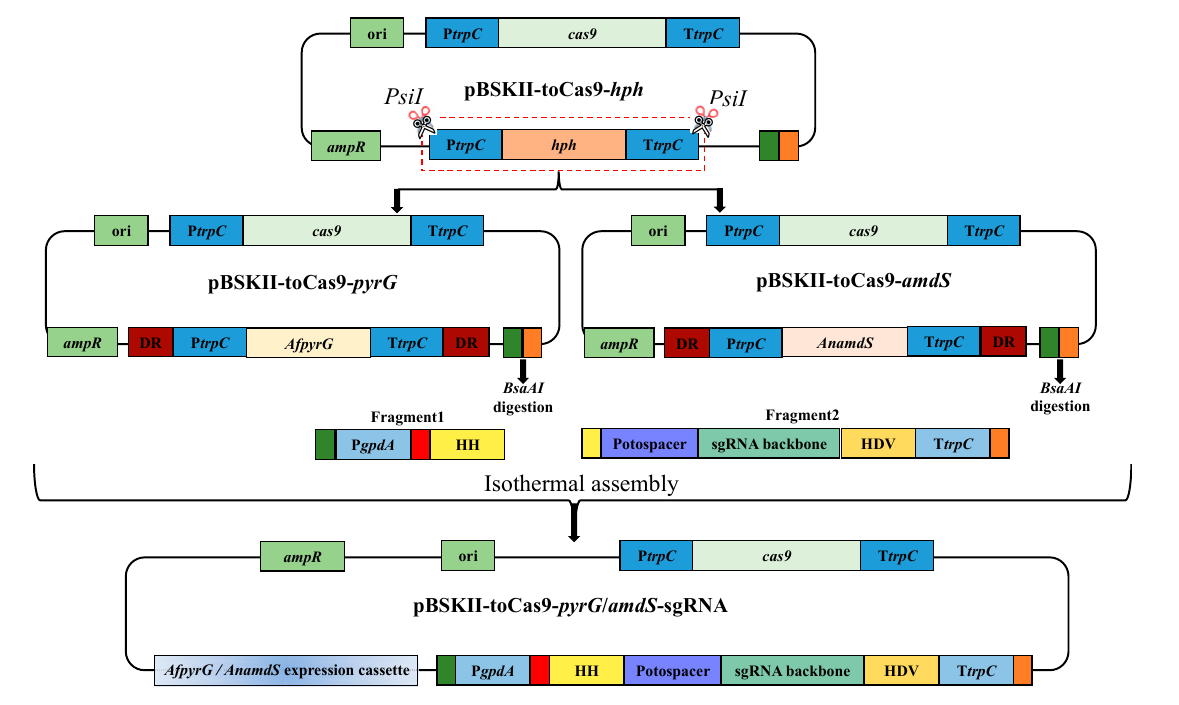
Figure 1. The construction of new CRISPR ‐ Cas9 vectors (pBSKII ‐ toCas9 ‐ pyrG / amdS ‐ sgRNA) for multistep gene deletion in marine ‐ derived fungi. The sequence of the pyrG / amdS expression cassette including P trpC promoter, T trpC terminator, and direct repeat was amplified. Then the amplified fragments were ligated into PsiI digested pBSKII ‐ toCas9 ‐ hph vector using isothermal assembly to generate two vectors named pBSKII ‐ toCas9 ‐ pyrG and pBSKII ‐ toCas9 ‐ amdS which were further digested by the BsaAI restriction enzyme for building the final gene disruption construct. The Fragment1 and Fragment2 were amplified by Frag1 F/R and Frag2 F/R primers using FC330 plasmid as a template, respectively. The resultant PCR products of flanking regions and the BsaAI ‐ digested pBSKII ‐ toCas9 ‐ pyrG / amdS plasmid can be joined together to form the final construct pBSKII ‐ toCas9 ‐ pyrG/amdS ‐ sgRNA. For simplicity, all complementary ends are visualized in the same color and no DNA elements in the above figure are drawn to scale.